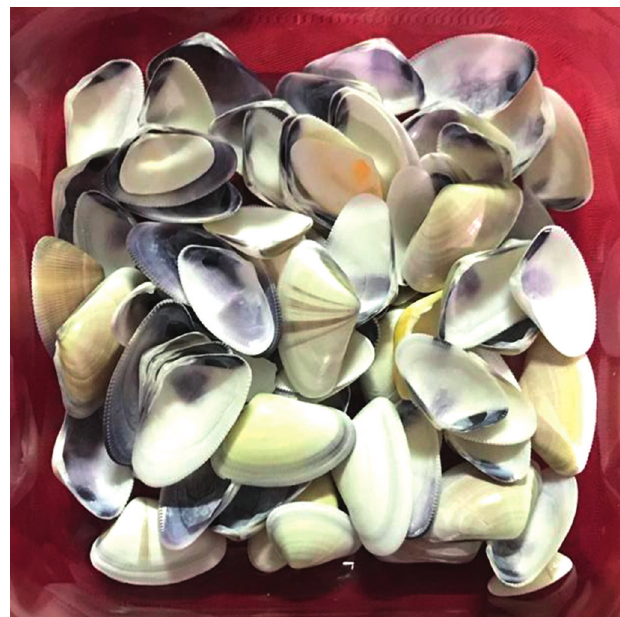
Figure 1: Collection and selection of mollusk shells ( Donax obesulus